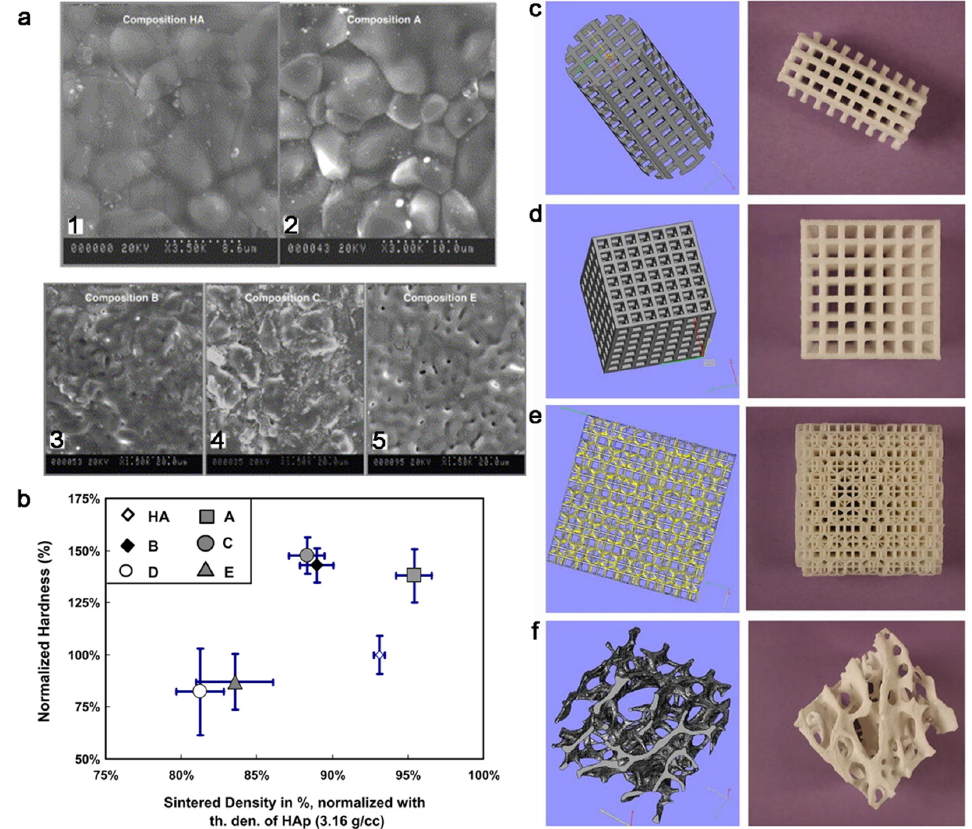
Figure 10. ( a ) SEM micrographs illustrating microstructures of (1) pure hydroxyapatite (HAP) and HAP with 2.5wt% of (2) 100% CaO, (3) 55% CaO + 30% P 2 O 5 + 15% Na 2 O, (4) 30% CaO + 30% P 2 O 5 + 40% Na 2 O, and (5) 17.2% CaO + 61.4% P 2 O 5 + 21.4% Na 2 O. ( b ) Variation in Vickers micro hardness values of sintered compacts of different compositions as a function of their sintered densities. Reproduced with permission [120]. Copyright 2004, Elsevier. ( c – e ) 3D models and relative selective laser sintering (SLS) manufactured scaffold for medical application. ( f ) Micro-computer tomography of human trabecular bone tissue (left) and a mimetic tissue produced by SLS (right). Reproduced with permission [127]. Copyright 2012, Spring Nature.